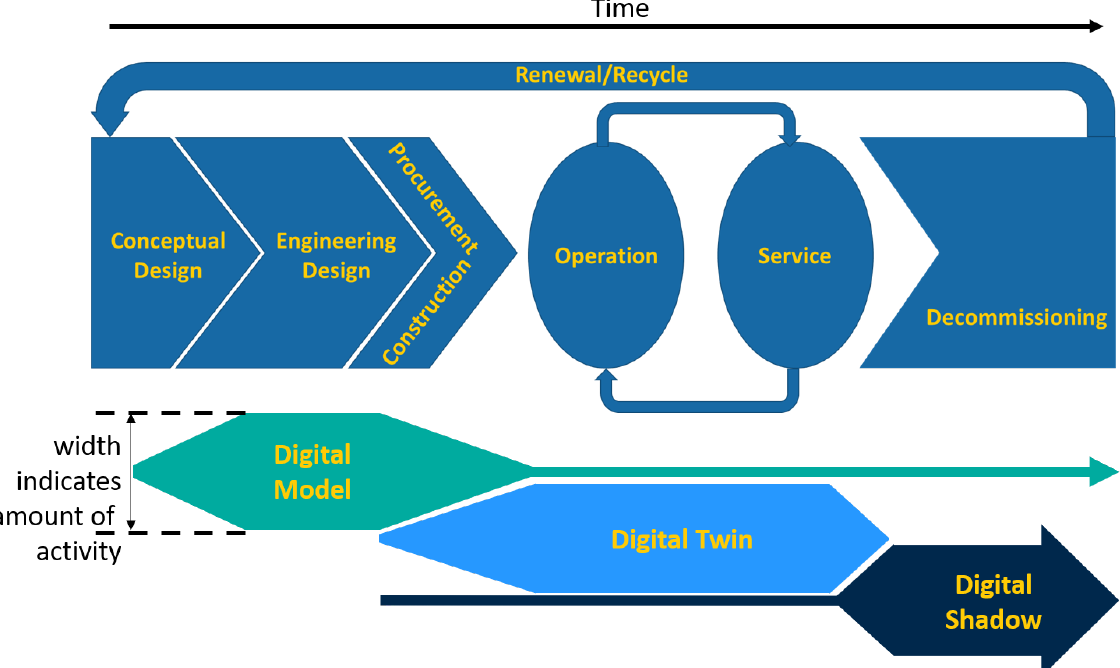
Figure 4. Illustration of physical asset life cycle phases and associated lifetimes and activity of the digital model, twin, and shadow. The width of these lifetimes indicates level of interaction with the digital